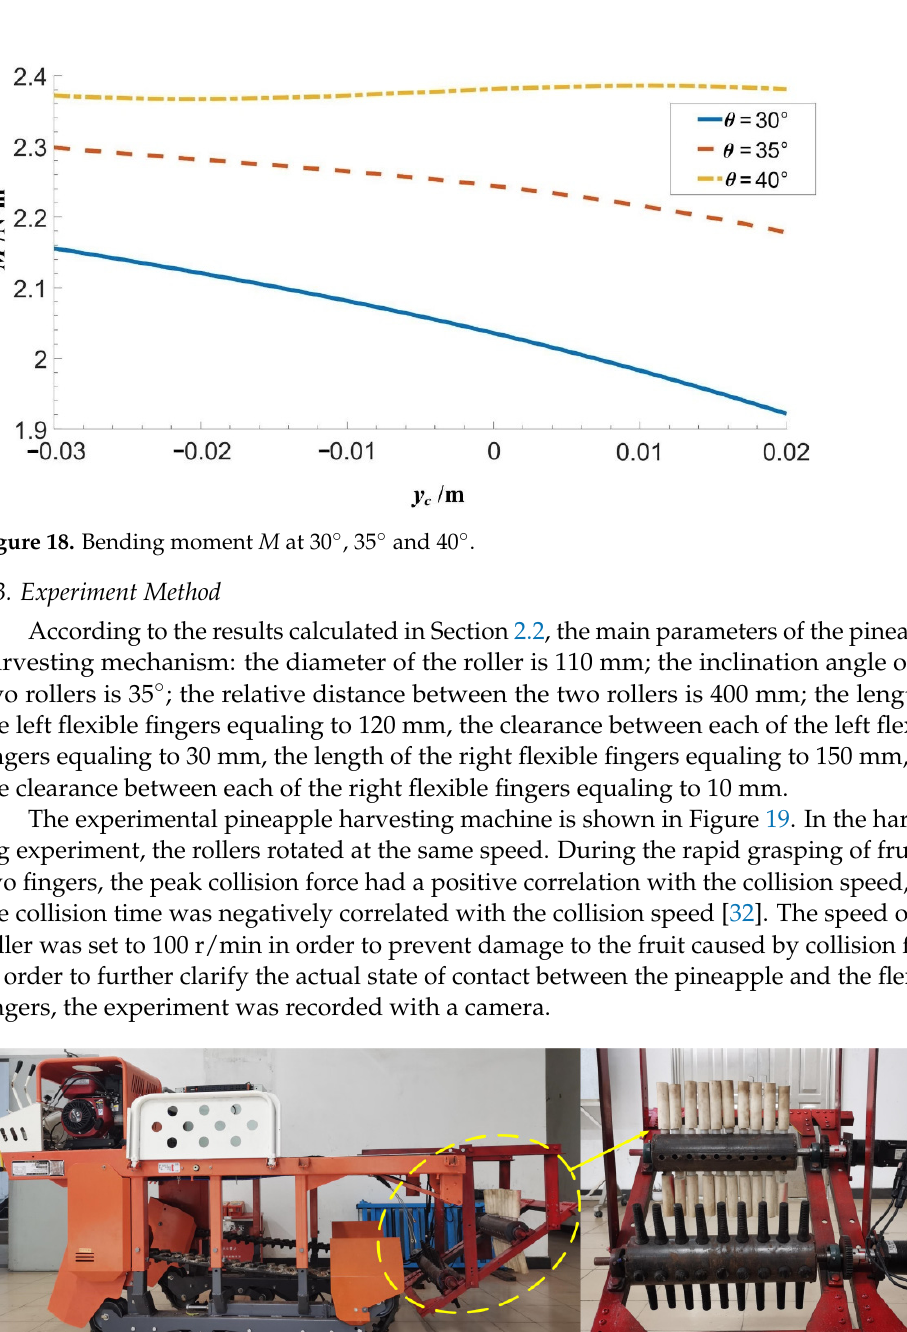
Figure 17. Force F A on the left flexible finger at 30°, 35° and 40°.